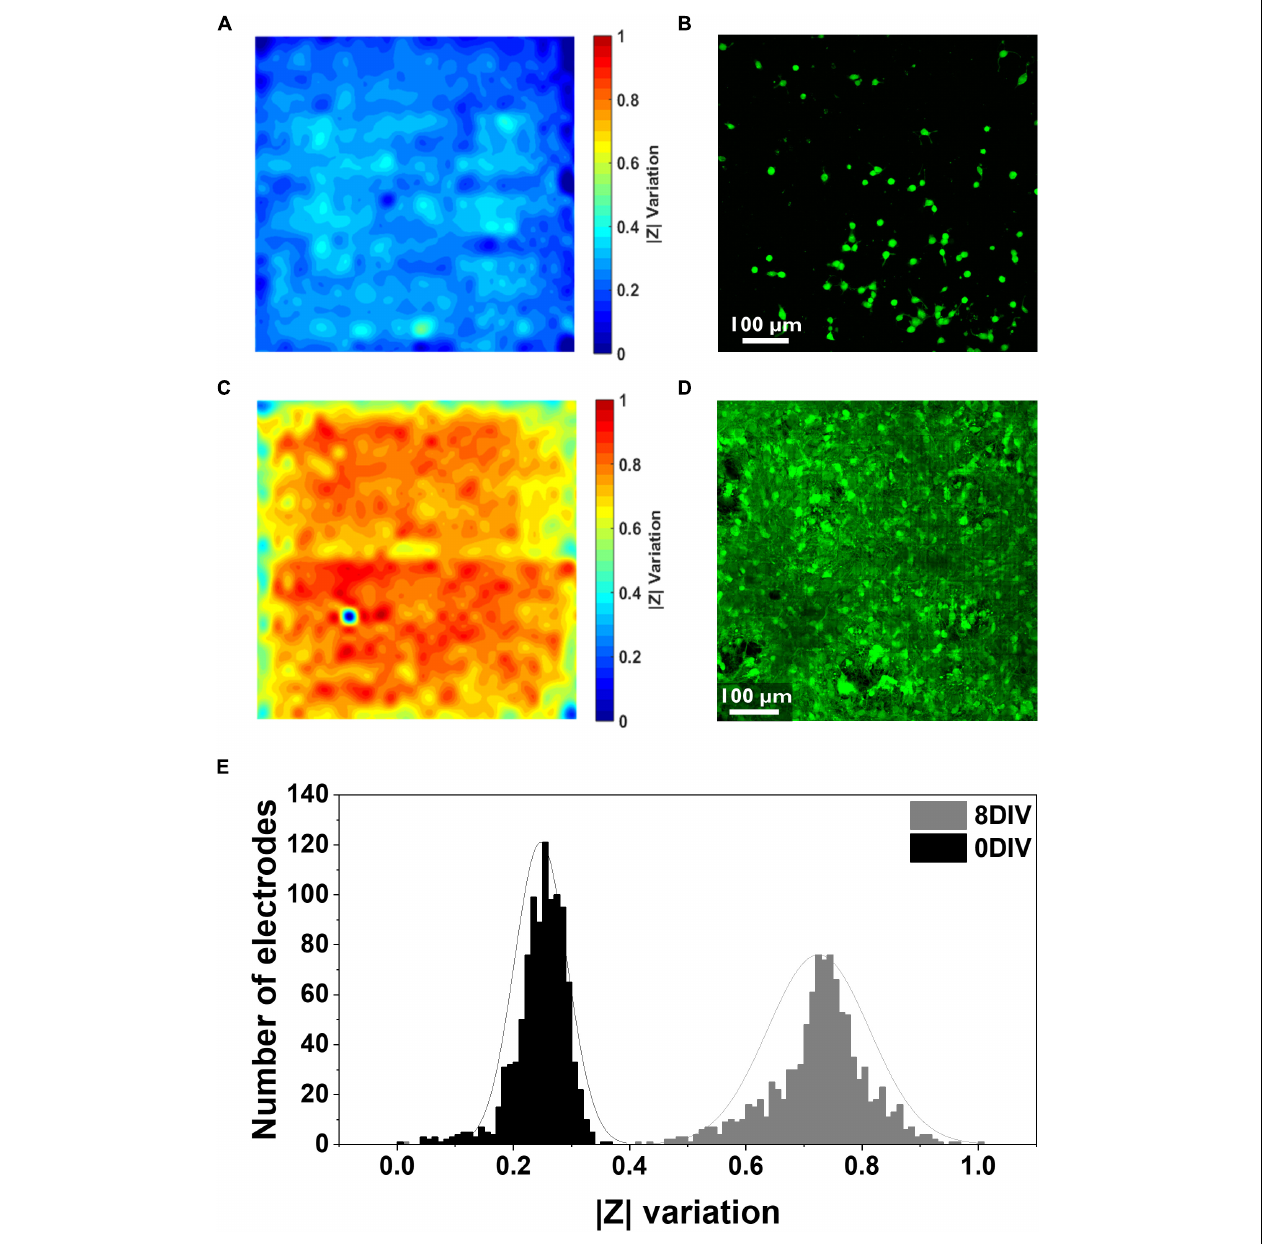
FIGURE 2 | Electrical and confocal imaging of primary hippocampal cultures at 0 and 8 DIV. (A,B) Electrical impedance map and confocal image of the cell culture stained with Calcein AM 4.5 h after seeding. (C,D) Electrical impedance map and confocal image of an 8 DIV confluent culture stained with Calcein AM. Both electrical and confocal images correspond to the same chip surface area (one active area, i.e., 1024 electrodes, 2500 µ m 2 ). (E) Histogram illustrating the distribution of the relative impedance variation recorded by 1024 electrodes for the 0 DIV (black) and 8 DIV (gray)